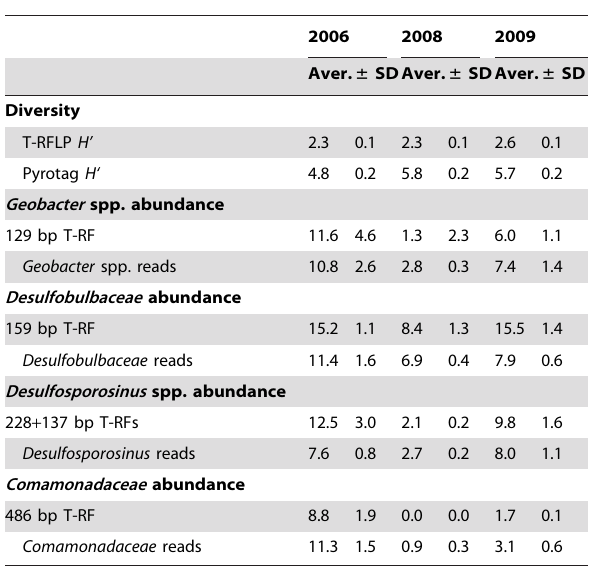
Table 1. Reproducibility and comparison of Shannon diversity ( H ’) and selected OTU abundance in T-RFLP fingerprinting and pyrotag libraries.